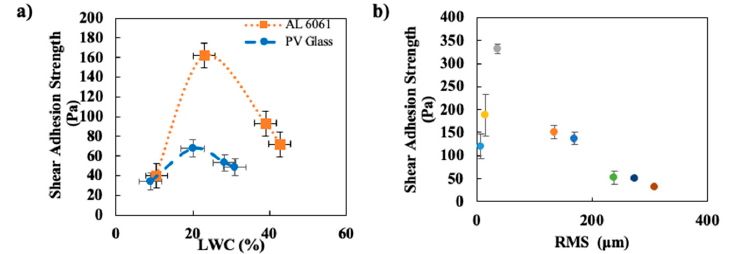
Figure 4. Impact of LWC and surface roughness on snow adhesion strength. ( a ) Results of snow shear adhesion strength on aluminum (Al) 6061 and photovoltaic (PV) glass. Maximum snow adhesion strength values are observed on both substrates, when the LWC of snow is around 20%. ( b ) Results are shown for shear adhesion strength (at LWC of ~22%) of snow on aluminum 6061 substrates as a function of surface roughness (RMS = 7 to 308 μ m).